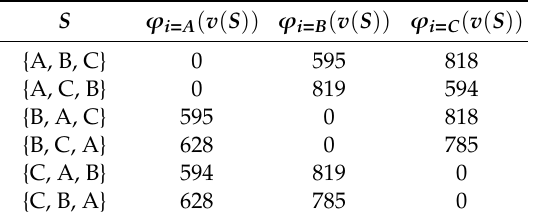
Table 2. The margin contribution of each